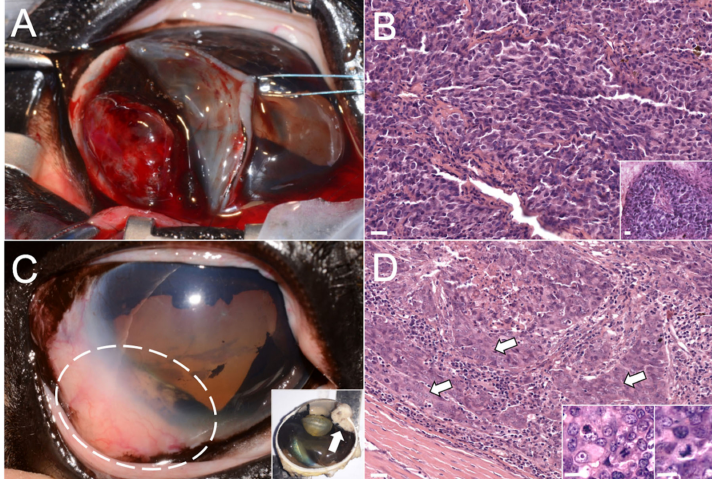
Figure 1. Photographs and photomicrographs of the masses that a ff ected the right eye. ( A ) Gross picture of the primary intraocular mass during the sector iridectomy. ( B ) Photomicrograph of the primary intraocular mass, hematoxylin and eosin (HE) stain; bar = 10 µ m. Inset: detail of the pseudo-rosette formation. HE stains, bar = 10 µ m. ( C ) Gross picture of the second intraocular mass in the same intraocular location (dashed circle), sagittal section (after enucleation) in the inset (arrow). ( D ) Photomicrograph of the second intraocular neoplasia, squamous di ff erentiation indicated by arrows. HE stain; bar = 10 µ m. Inset: detail of bizarre mitotic figures. HE stains, bar = 5 µ